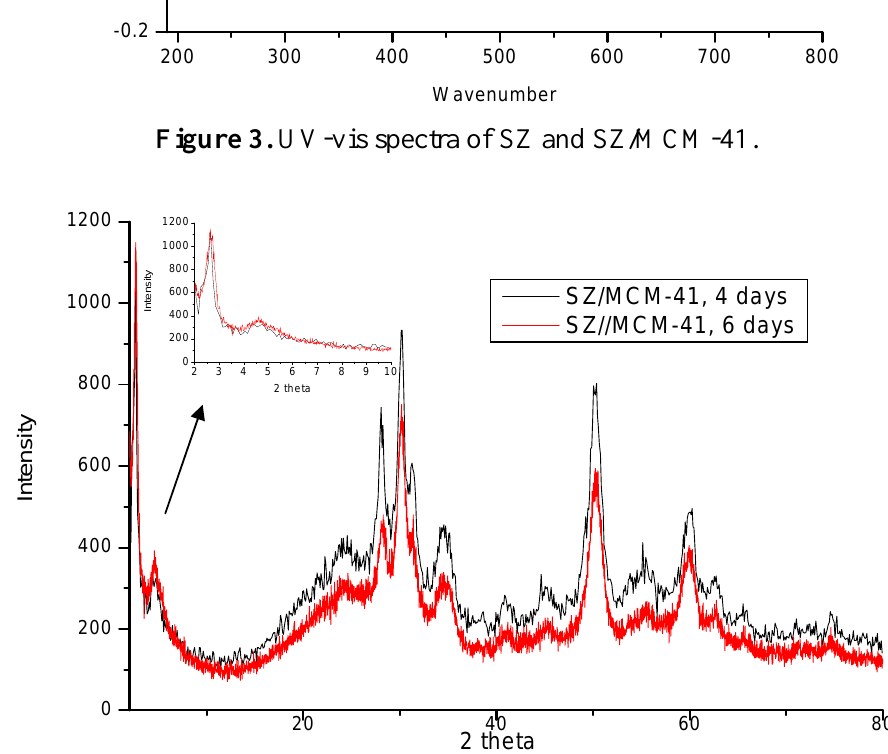
Figure 4. XRD of SZ/MCM-41 dried 4 and 6